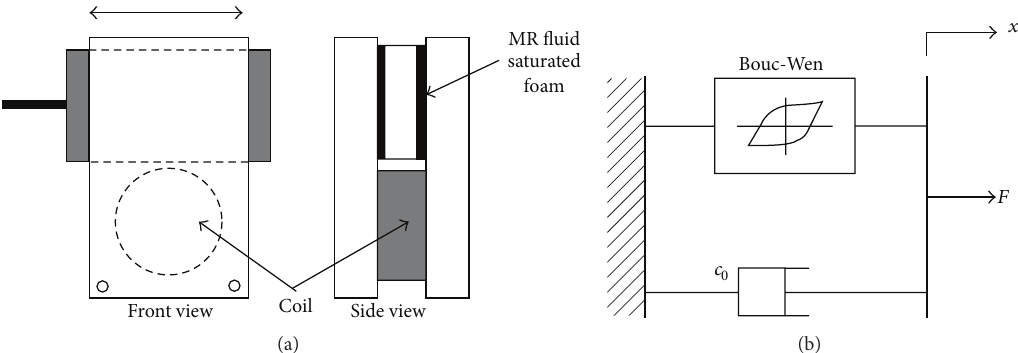
Figure 20: (a) Schematic diagram of shear mode MR damper; (b) mechanical model of the parallel plate MR damper [15, 18, 19].